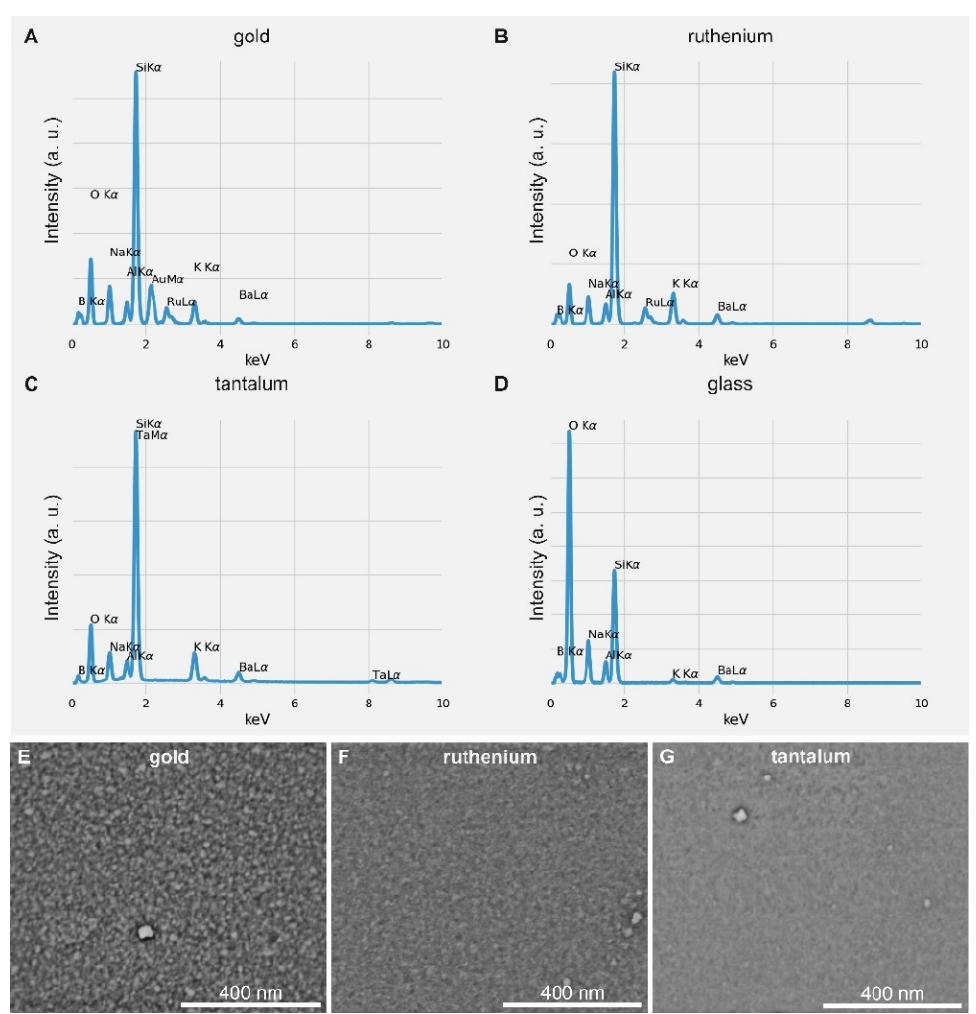
Figure 2. EDX spectra of three different metal coatings and pure glass, where ( A – C ) depict the EDX spectra of gold— ( A ), ruthenium— ( B ) and tantalum— ( C ) coated glass and ( D ) depicts the EDX spectrum of the uncoated glass surface. SEM images of the three different metal coatings, where ( E ) shows the gold surface, ( F ) the ruthenium surface and ( G ) the tantalum